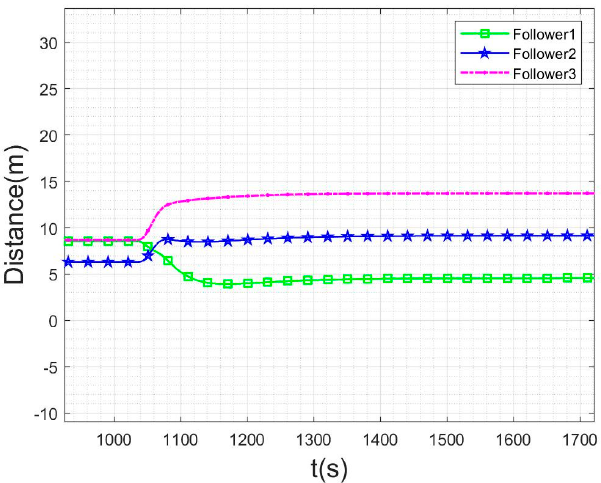
Figure 19. Position of the followers relative to the leader during the formation change.